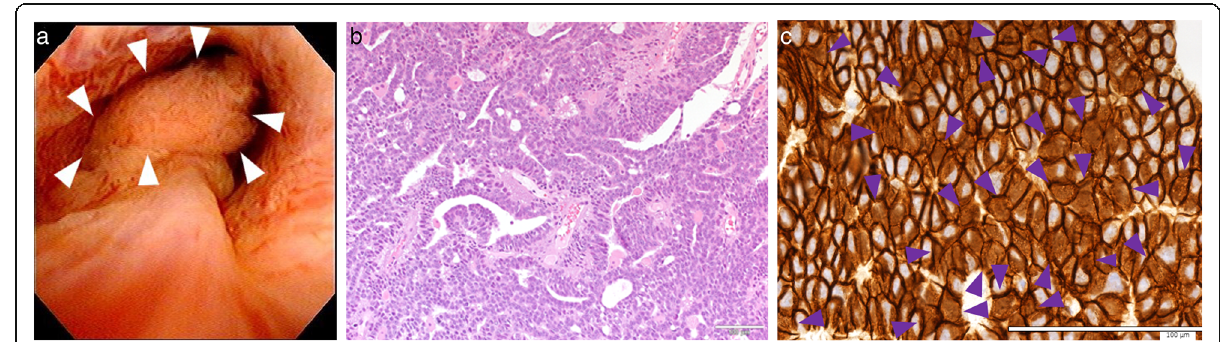
Fig. 1 a Tumor in the urethra with representative images of hematoxylin and eosin (HE) ( b ) and β -catenin ( c ) staining. HE staining showed papillary architecture with morphological features of ductal adenocarcinoma including tall, columnar, pseudostratified epithelium. Focal nuclear β - catenin staining is seen (arrows in c). Bars indicate 100 μ